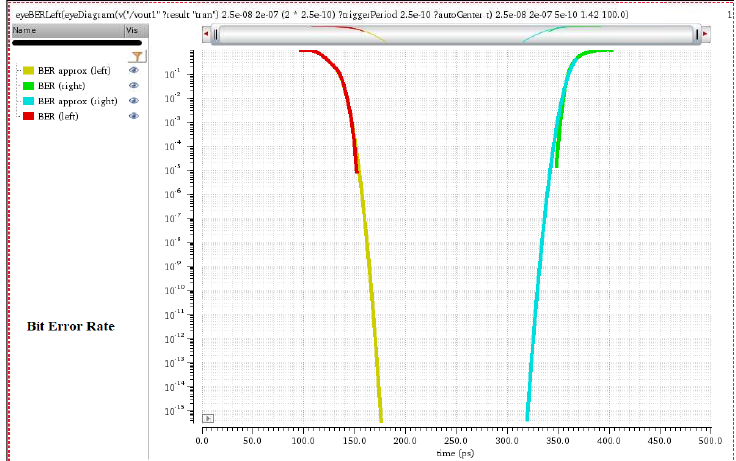
Figure 16. Simulated BER(t) bathtub curves for the 6 Gb/s NRZ signal. Table 1. Performance comparison.